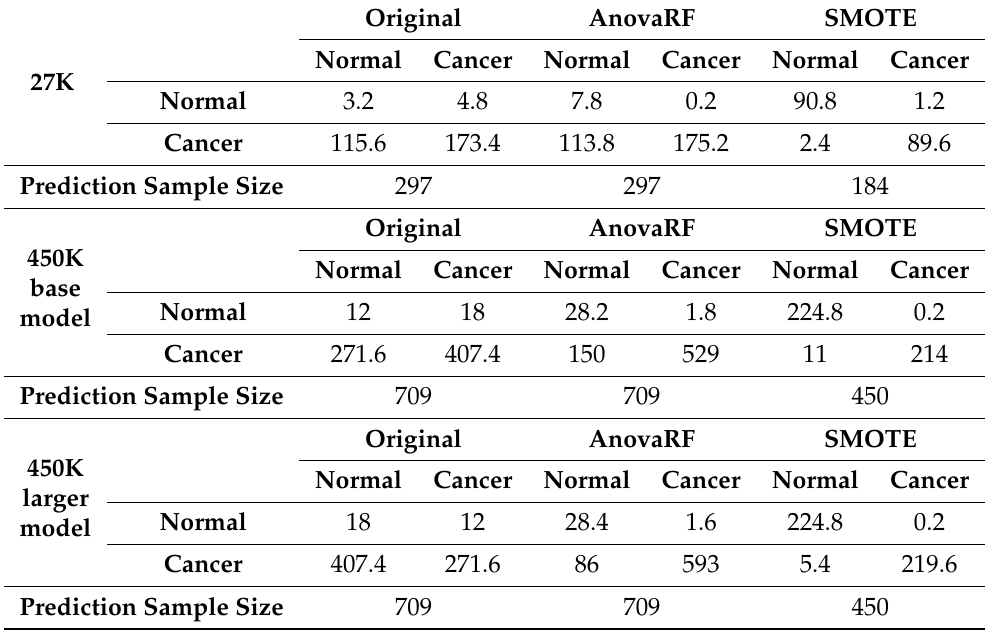
Table A4. Confusion matrices of deep learning model on 27K and 450K datasets showing average outcome of five trials. Columns represent prediction and rows represent actual values. It can be observed that without SMOTE application and deep learning, majority of samples have been predicted as cancer.